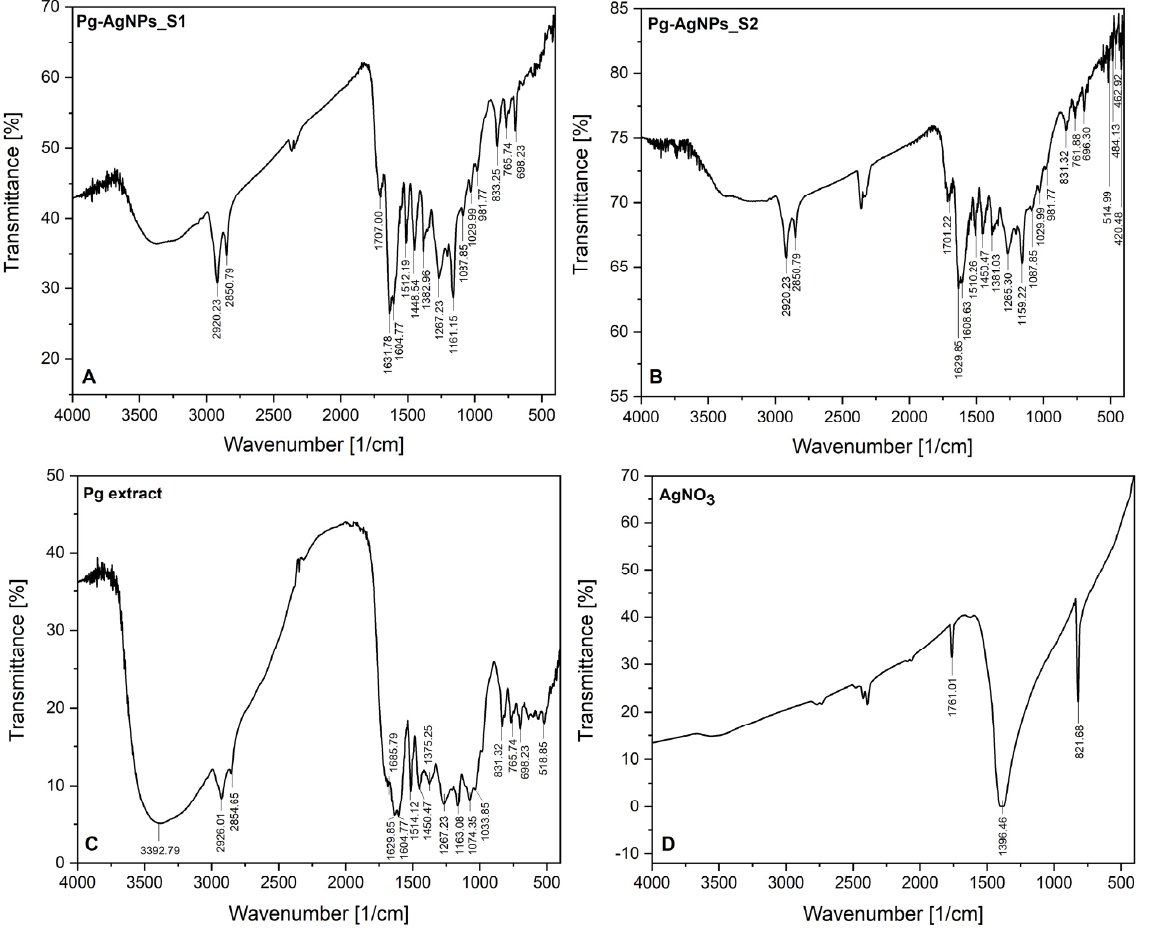
Figure 2. FT—IR spectra: ( A )—Pg-AgNPs_S1 spectrum from Pg extract, obtained at 25 ◦ C by green Figure 2. FT − IR spectra: ( A ) − Pg-AgNPs_S1 spectrum from Pg extract, obtained at 25 °C by green synthesis; ( B )—Pg-AgNPs_S2 spectrum from Pg extract, obtained at 60 ◦ C by green synthesis; ( C )—Pg synthesis; ( B ) − Pg-AgNPs_S2 spectrum from Pg extract, obtained at 60 °C by green synthesis; ( C ) − Pg ethanolic dried extract; ( D ) − AgNO 3 spectrum. ethanolic dried extract; ( D )—AgNO 3